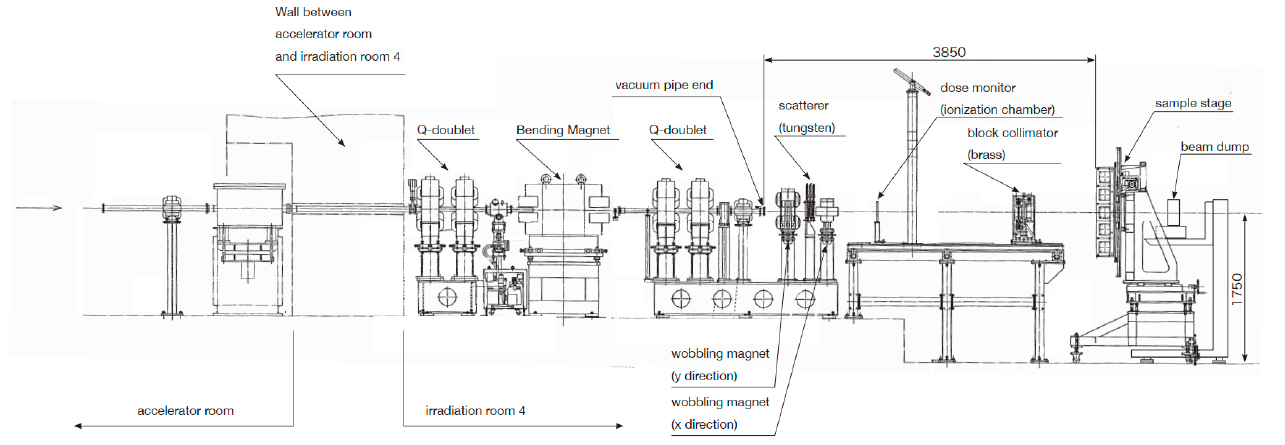
Figure 5. Beam line in irradiation room 4.